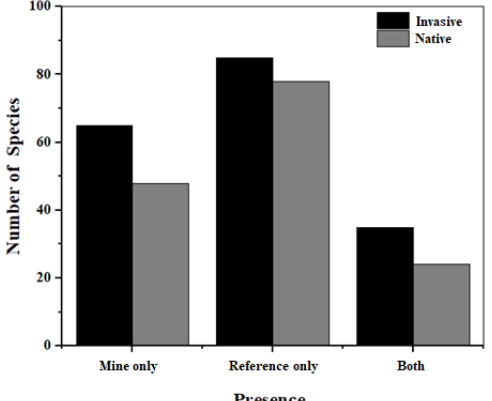
Figure 3. The total number of invasive and native plant species present across site type combinations.